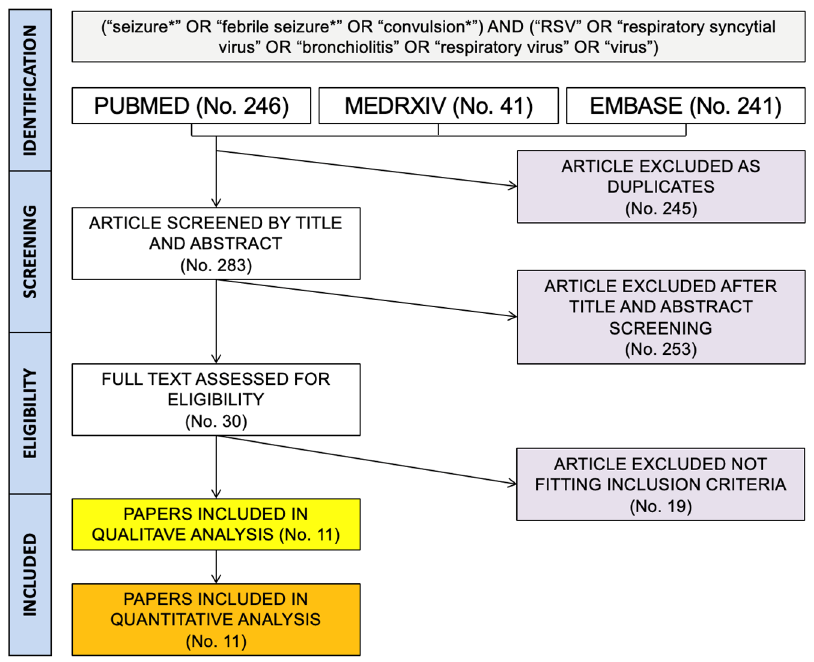
Figure 1. Flow chart of the studies included in the present systematic review and meta-analysis. Table 2. Summary of included